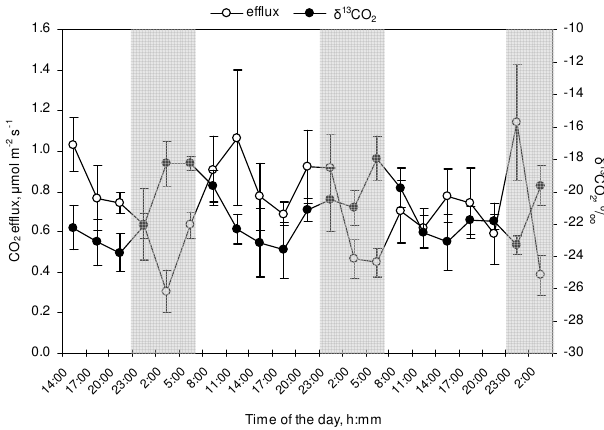
Fig. 4. 13 C of the soil CO 2 and soil respiration rates, obtained with Keeling plot technique. White and grey hatching of the graph indi- cate day and night periods. Bars represent the standard error of the mean ( n =